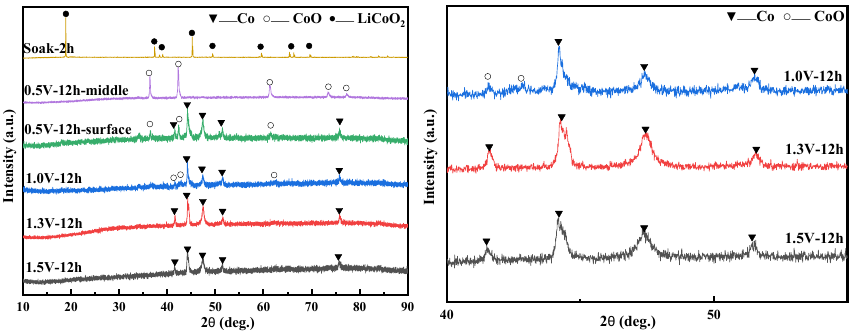
Figure 8. XRD of products electrolyzed at different voltages for 12 h.